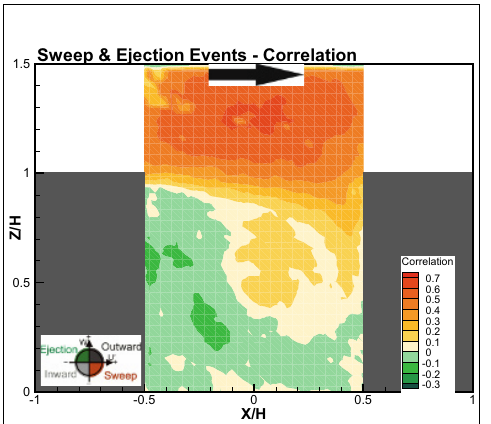
Fig. 10: Correlation between time-series created by insert- ing sweep (with true sign) and ejection (with inverse sign) in all points in the canyon from and time-series Figure